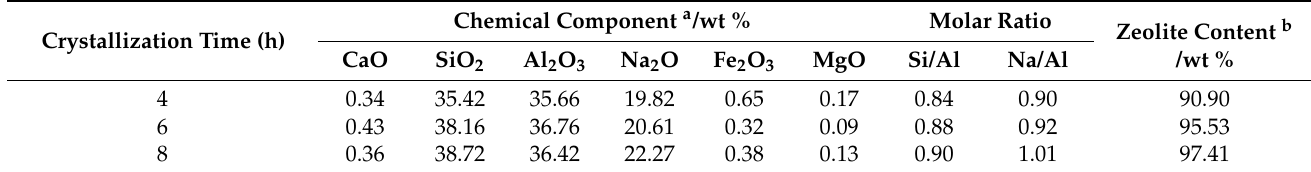
Table 2. Chemical components and Si/Al (Na/Al) molar ratio of the obtained BFSZ. Chemical Component a /wt Crystallization Time (h)